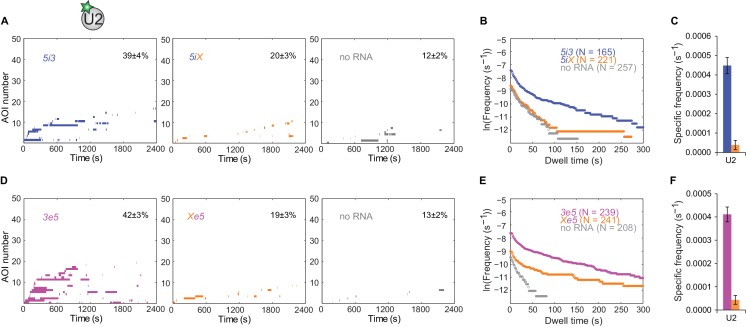
U2 binding events to pre-mRNA depend on the polypyrimidine tract and 3'SS.(A) Rastergrams showing U2 binding data on 50 randomly selected individual 5i3 and 5iX pre-mRNA molecules and 'no RNA' control locations over the course of 2,400 s, sorted by the time of the first binding event to each RNA. The percentage (±s.e.) of N observed RNA molecules that exhibited subcomplex binding during the experiment is indicated. (B) Cumulative dwell time distributions of U2 binding events on wild-type 5i3 and mutated 5iX cross-intron RNAs, and at randomly selected locations with no RNA. (C) Frequencies (±s.e.) of RNA-specific U2 binding to 5i3 and 5iX RNAs calculated as in Figure 2G. (D–F) Same as (A–C), except for the 3e5 and Xe5 RNAs. Data in all three panels are from the same experiment.10.7554/eLife.37751.023Figure 3—figure supplement 1—source data 1.Data from the single-molecule experiments.